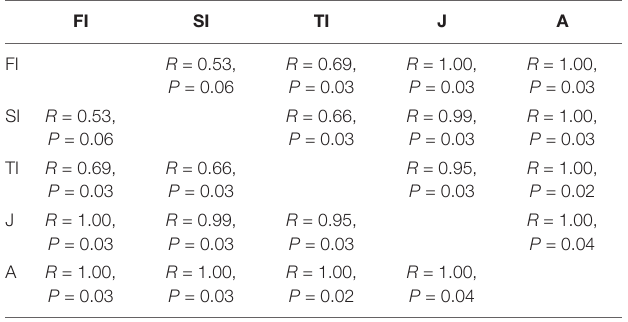
TABLE 2 | Analysis of similarities based on Bray–Curtis distance matrix.